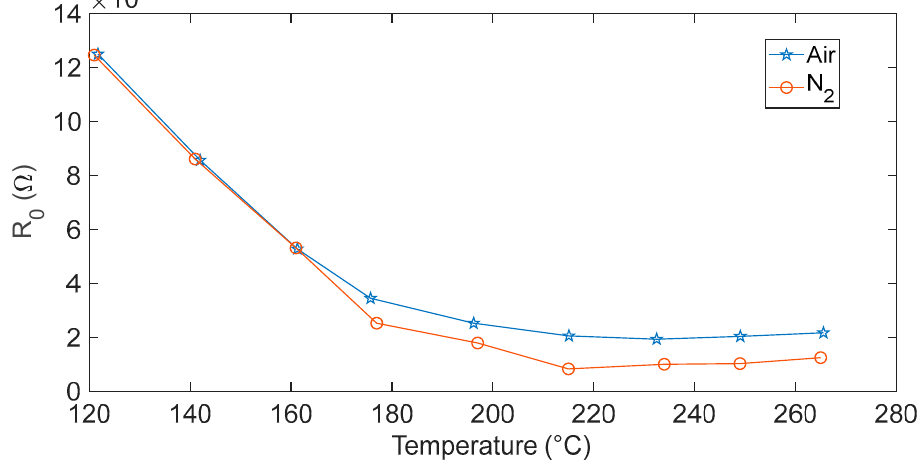
Figure 5. Measured baseline resistance of the In 2 O 3 − X sensor evaluated at different temperatures in air (blue line) and N 2 (red line) carrier